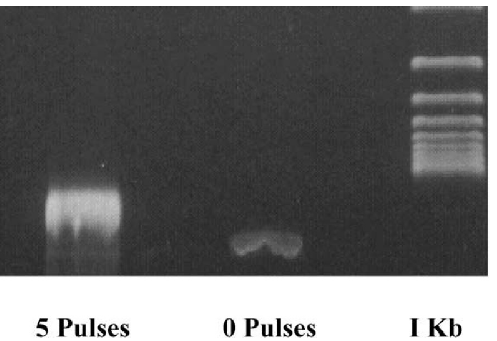
Figure 5. Electrophoresis of DNA extracted from Jurkat cells right after nsPEF (60 kV/cm, 60 ns, 5 pulses). The appearance of a smeared DNA band in the first lane is congruent with DNA damage induced by nsPEF. Taken from [247]. Reproduced with permission.